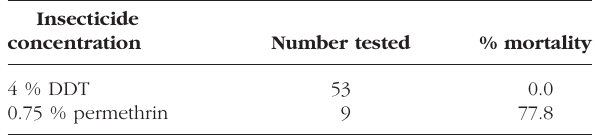
generation of 1